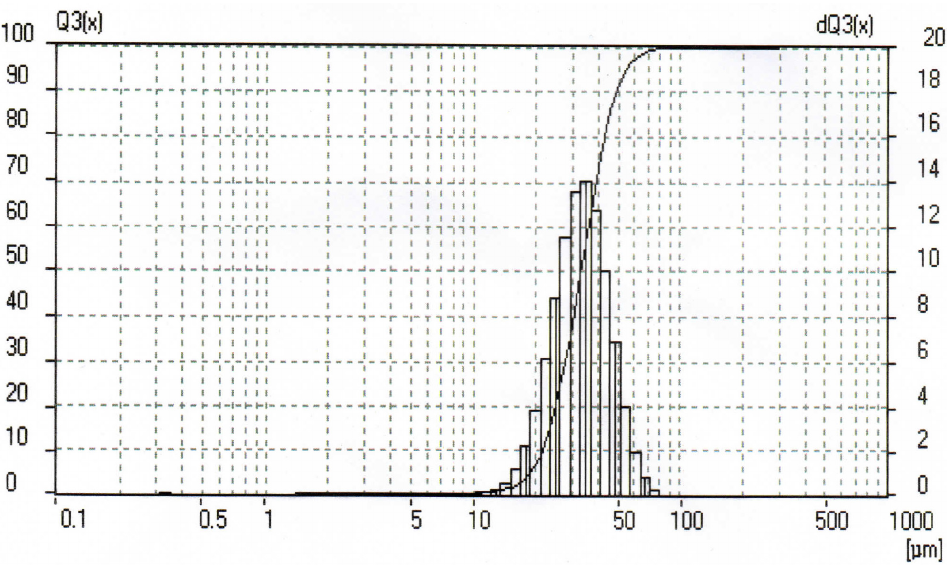
Figure 1. Aluminum powder particle size distribution histogram.